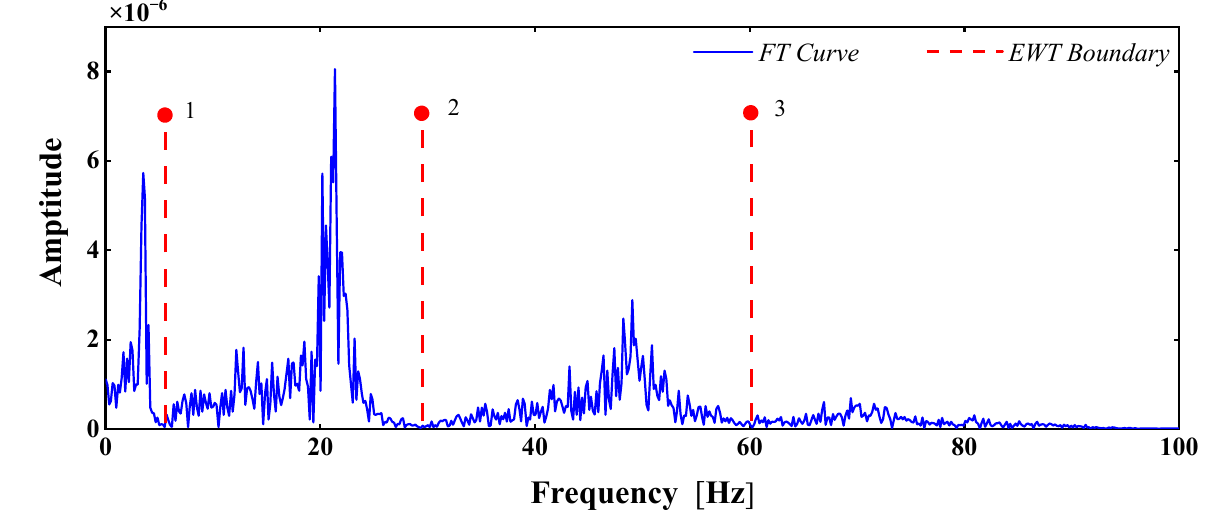
Figure 8. Strain spectrum splitting of measurement point 120 under scenario I.